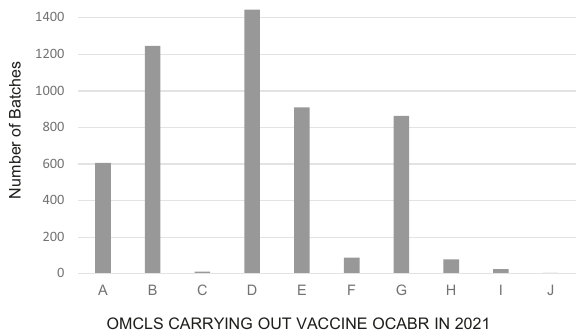
Fig. 2 Number of vaccine batches undergoing OCABR at each OMCL in 2021. OMCLs are represented anonymously by letter on the X-axis. The Y-axis represents number of batches, all vaccine types